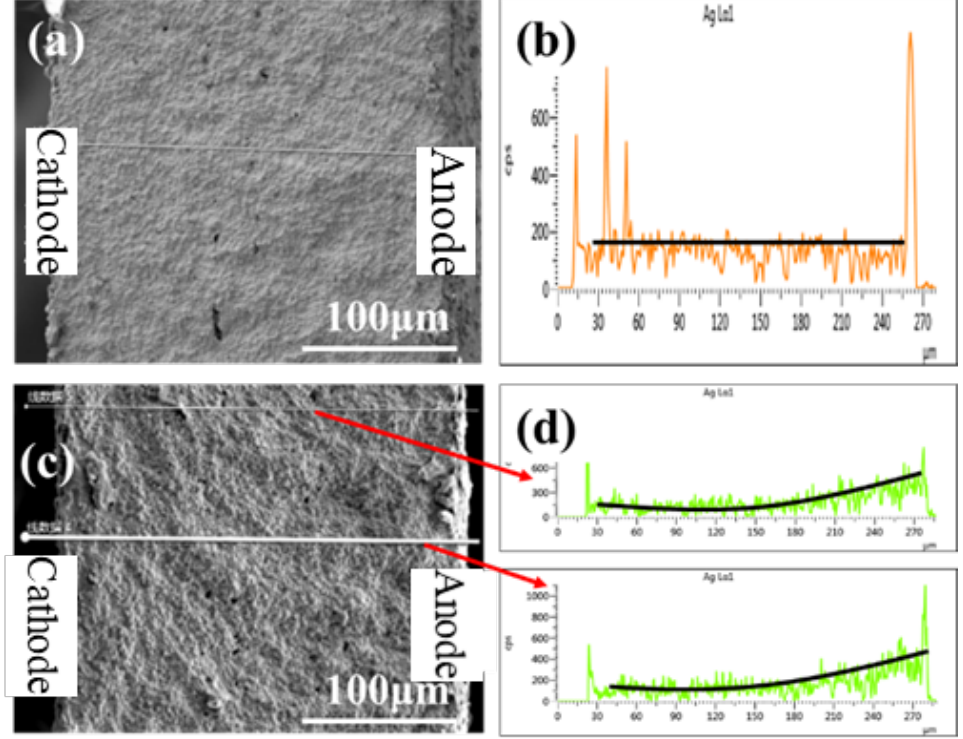
Figure 5: Ag elemental-distribution of sample 2# (a), (b) before electric degradation; (c), (d) after electric degradation